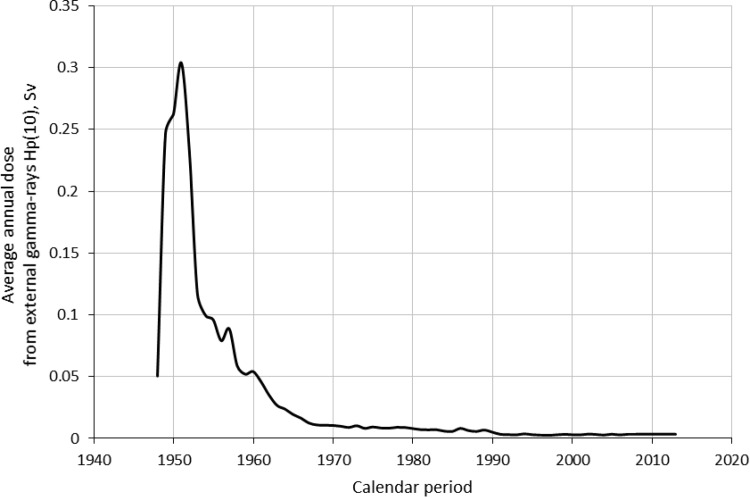
Average annual dose from external gamma-rays by calendar period.